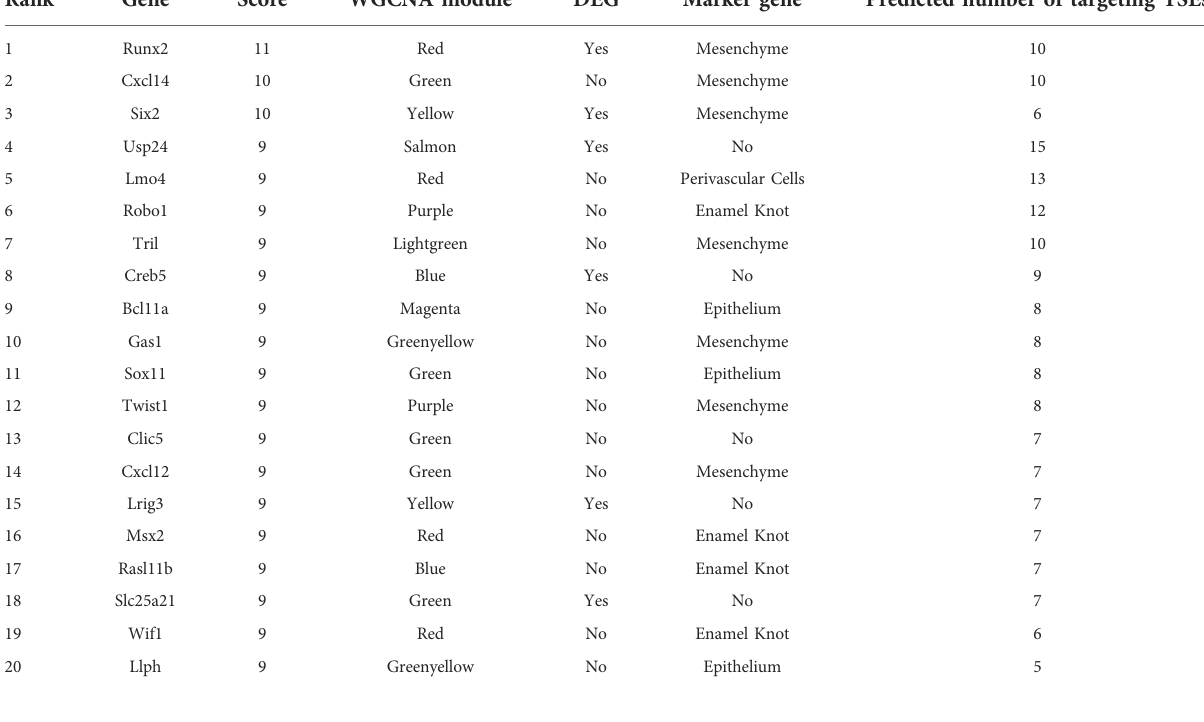
TABLE 1 Top 20 prioritized putative odontogenic